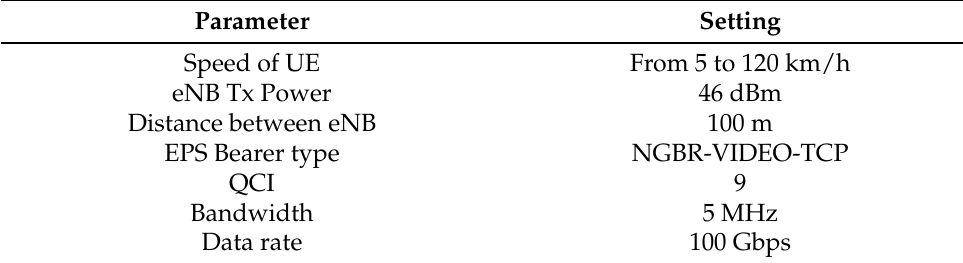
Table 2. Key parameters for